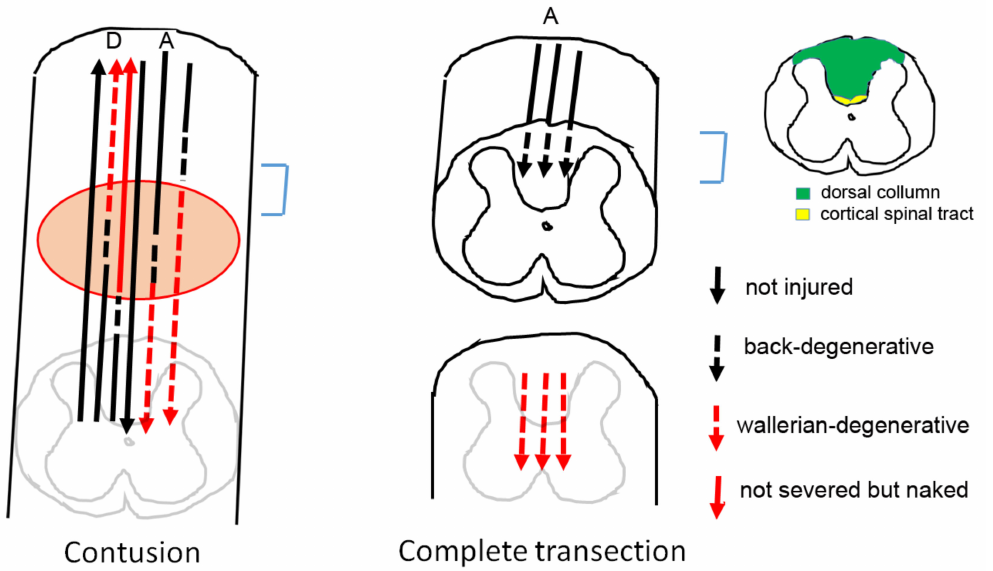
Figure 17. Comparison of white matter tract degeneration in contusion and complete transection model. D: descending tracks A: ascending tracks. In the caudal stump to the injury in the blue bracket area we saw a mixture of (left to right) descending not injured axon, descending Wallerian degenerative axon, descending not severed but naked axon, ascending no injured axon, and ascending back-degenerative axon. For the complete transection model, for the blue bracket area only ascending back-degenerative axon was